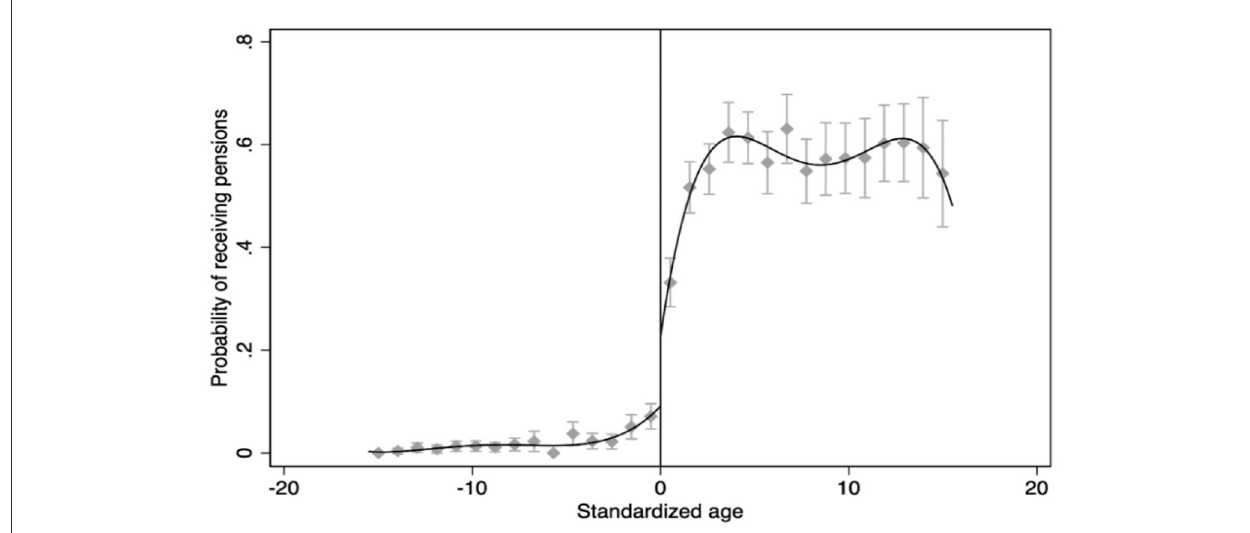
FIGURE1 The cutoff in the probability of receiving pensions at the standardized age 0. Source: CFPS2014 and Stata